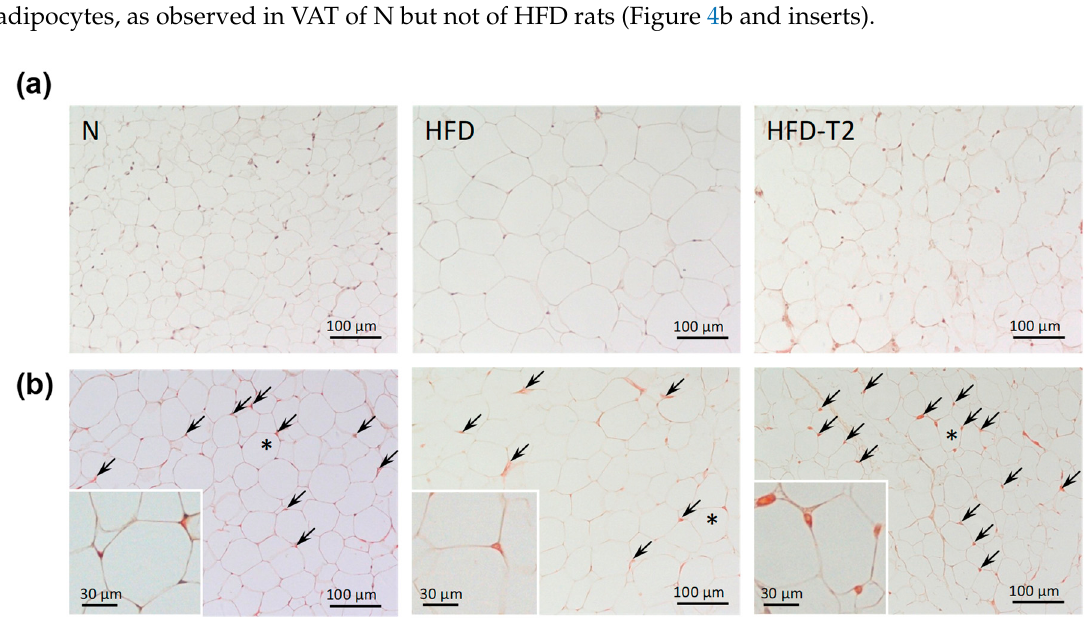
Figure 3. Effect of 3,5-T2 administration to rats fed a high-fat diet on signaling pathways underlying 45 VAT lipolysis. Representative immunoblot analysis for phosphorylation and representation of 46